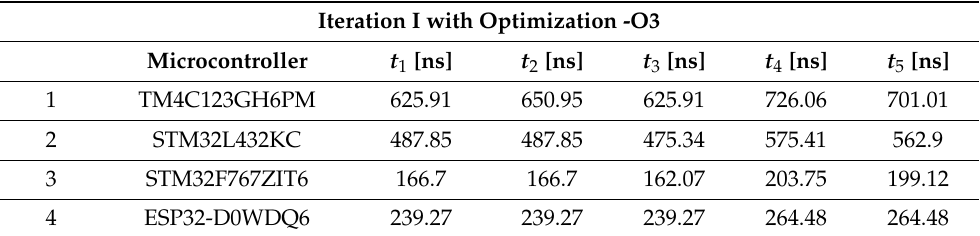
Table 2. Average function calculation times of InvCbrt(x) for Iteration I.